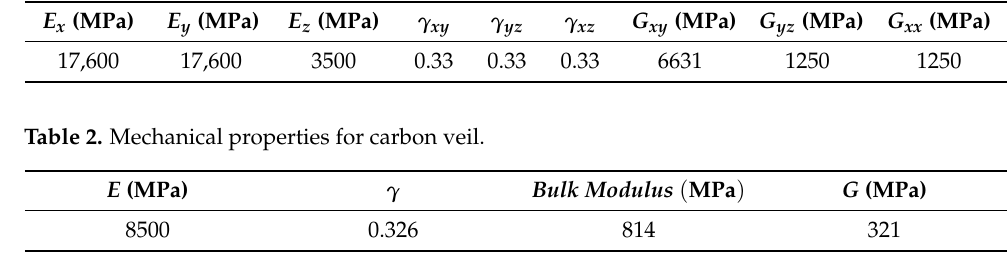
Table 1. Mechanical properties for gms ep-280 s-glass.